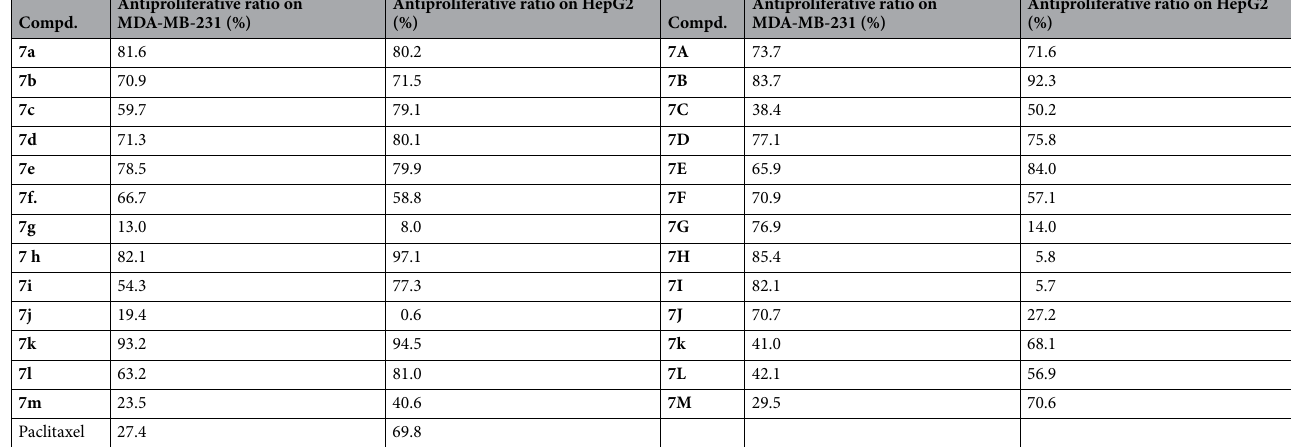
Table 1. Antiproliferative ratio of paclitaxel-benzoxazoles hybrids 7a – 7m and 7A – 7M against two cancer cell lines at 50